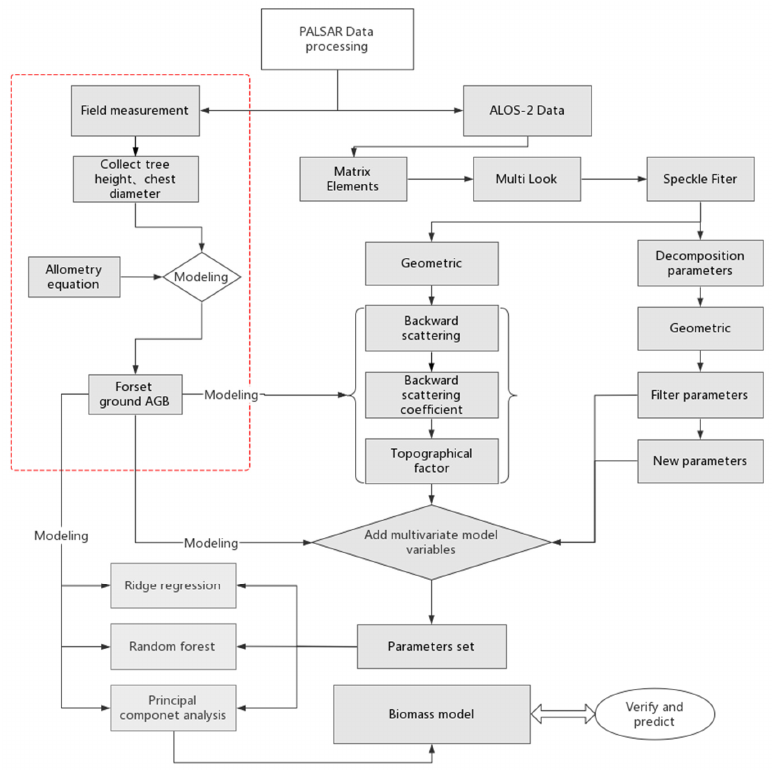
Figure 2. Figure 2. Flowchart.